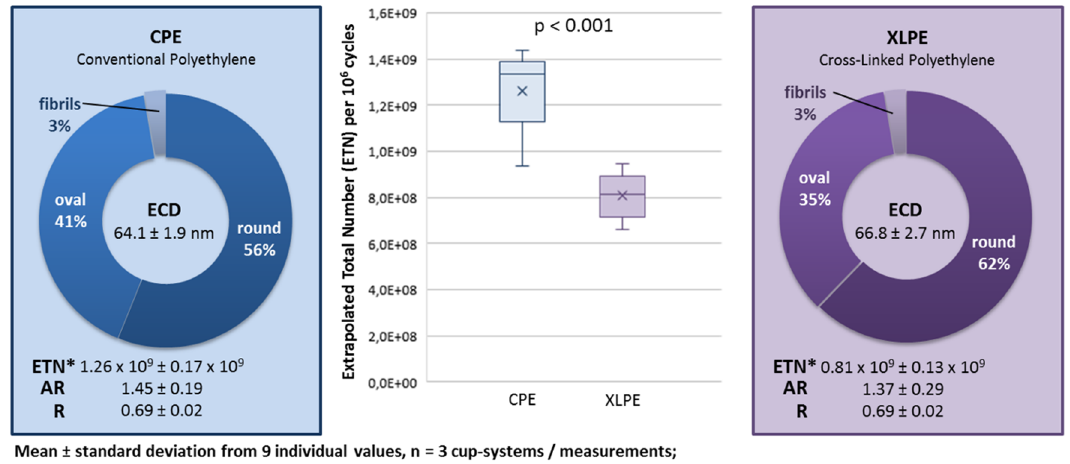
Figure 3. Results of the particle analysis and comparison between the conventional polyethylene (CPE) and cross-linked polyethylene (XLPE) backside wear.